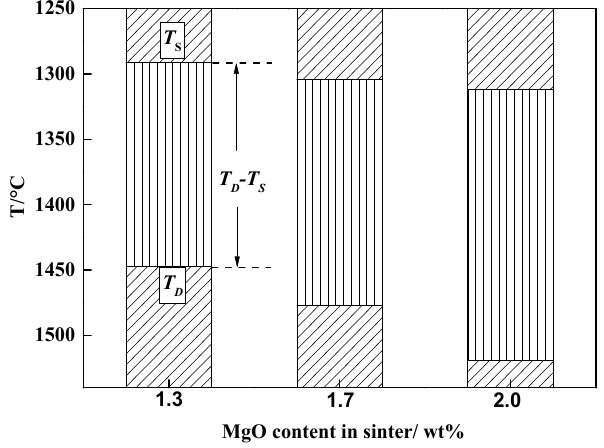
Figure 8. T S , T D and melting zone for different MgO content sinter.